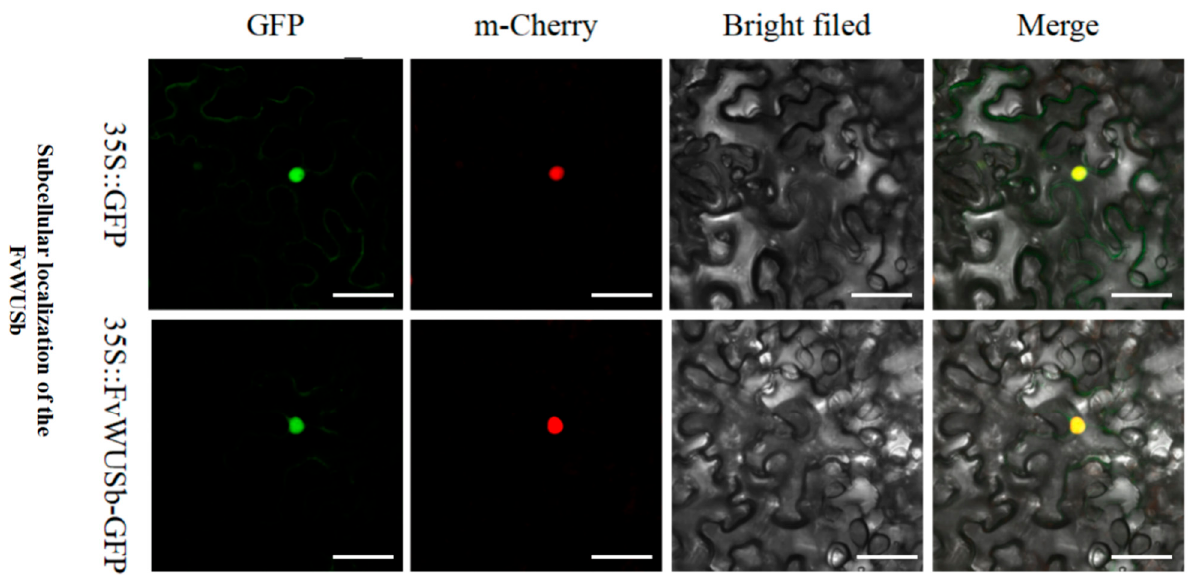
Figure 7. Subcellular localization of the FvWUSb protein. From left to right: GFP fluorescence, nuclear localization marker protein m-Cherry, bright field and merged microscope images. Scale bars = 25 µ m.